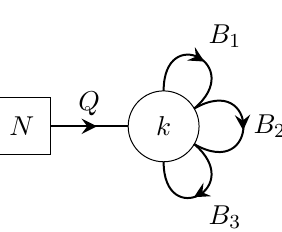
Figure 1. 2d N = (2 ; 2) quiver gauge theory with a U( k ) vector multiplet; Q , B a =1 ; 2 ; 3 chiral multiplets; SU( N ) (cid:13)avour symmetry (in section 2 we take N = 1). The superpotential is W = Tr ( B 1 [ B 2 ; B 3